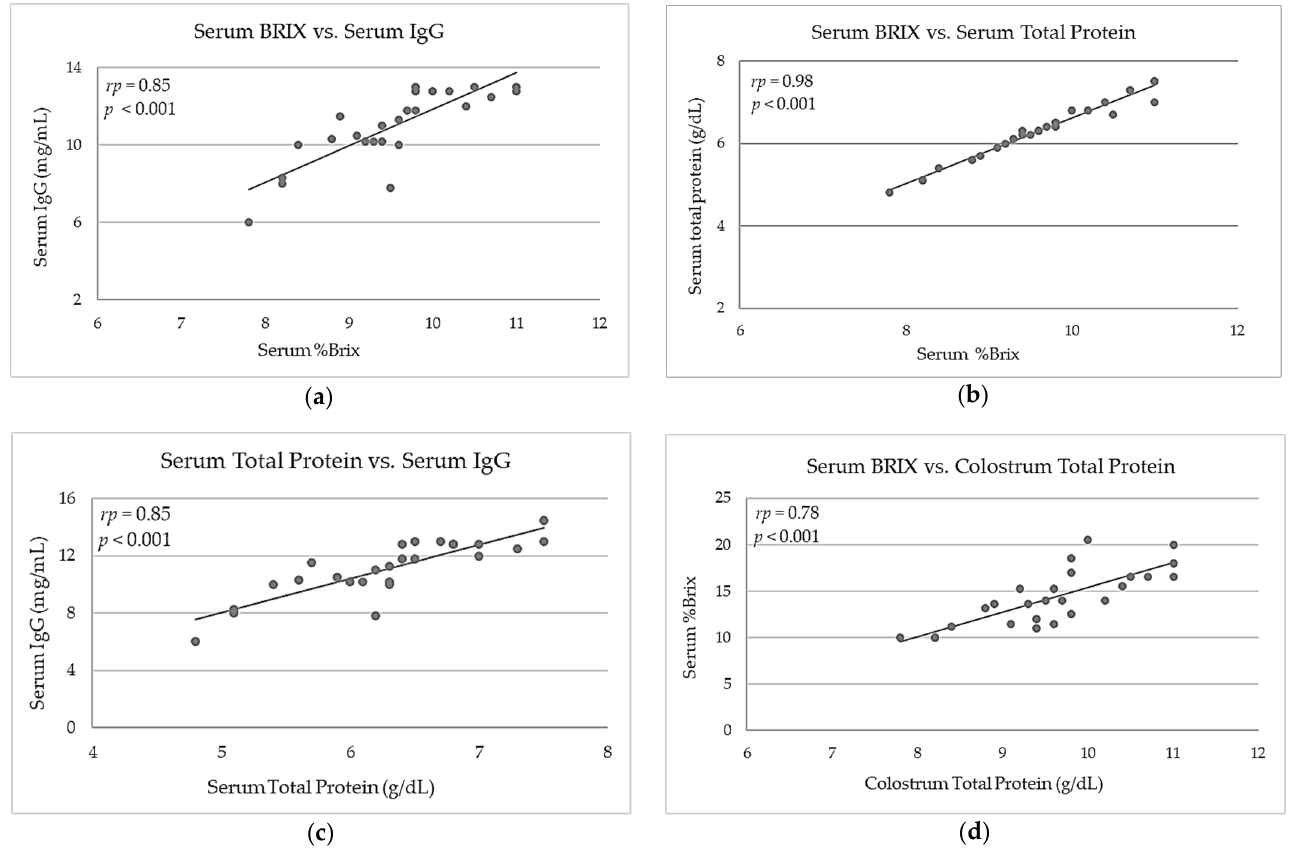
Figure 2. ( a ) Relationship between calf serum %Brix (at 72 h) and serum IgG (mg/mL) (at 72 h) ( r p = 0.85, p < 0.001); ( b ) Correlation between calf serum %Brix and serum total protein (STP, g/dL) ( r p = 0.98, p < 0.001); ( c ) Correlation between serum total protein (g/dL) and serum IgG (mg/mL) ( r p = 0.85, p < 0.001); ( d ) Relationship between serum %Brix and colostrum total protein (g/dL) ( r p = 0.78, p < 0.001). r p is the Pearson’s coefficient of correlation.